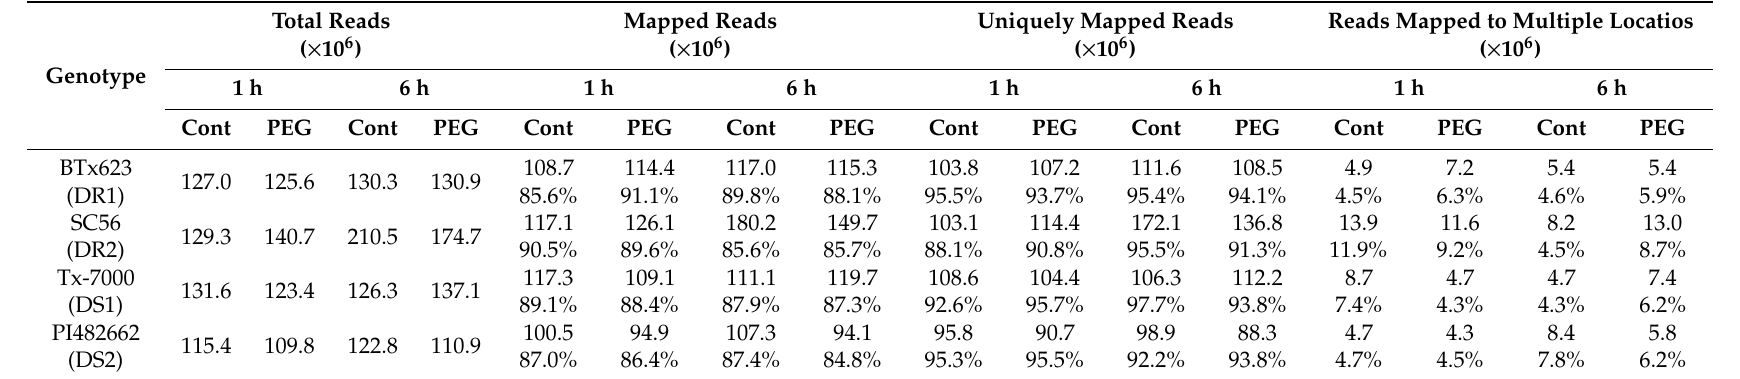
Table 1. Alignment statistics of RNA-seq reads to the reference